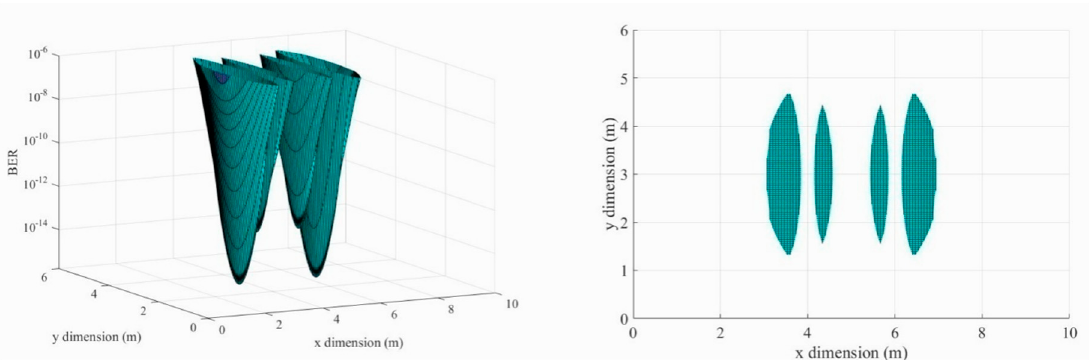
Figure 7. Areas with a bit error rate (BER) ≤ 1 × 10 − 6 for case where the VO 2 filter is applied at the receiver of the visible light communication (VLC) system.